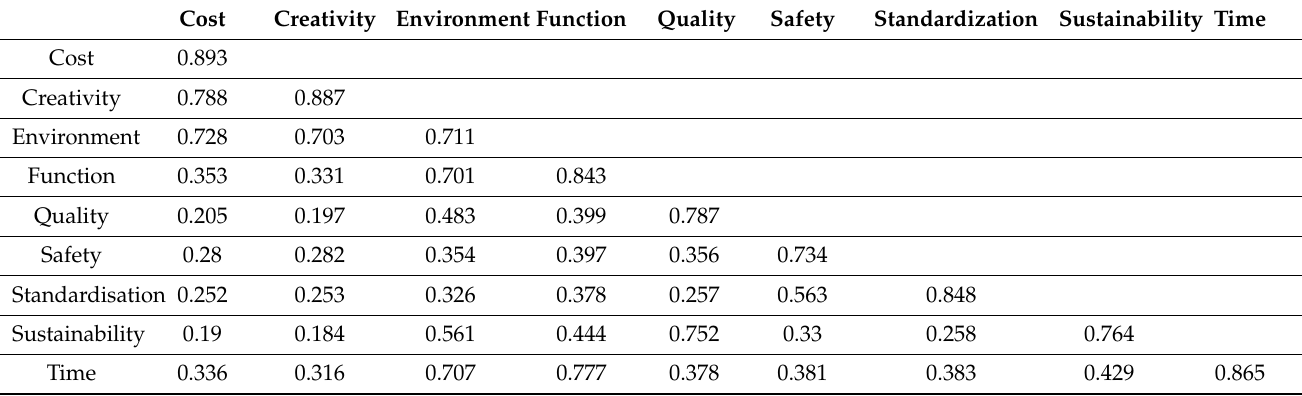
Table 5. Correlations of latent variables and discriminant validity.